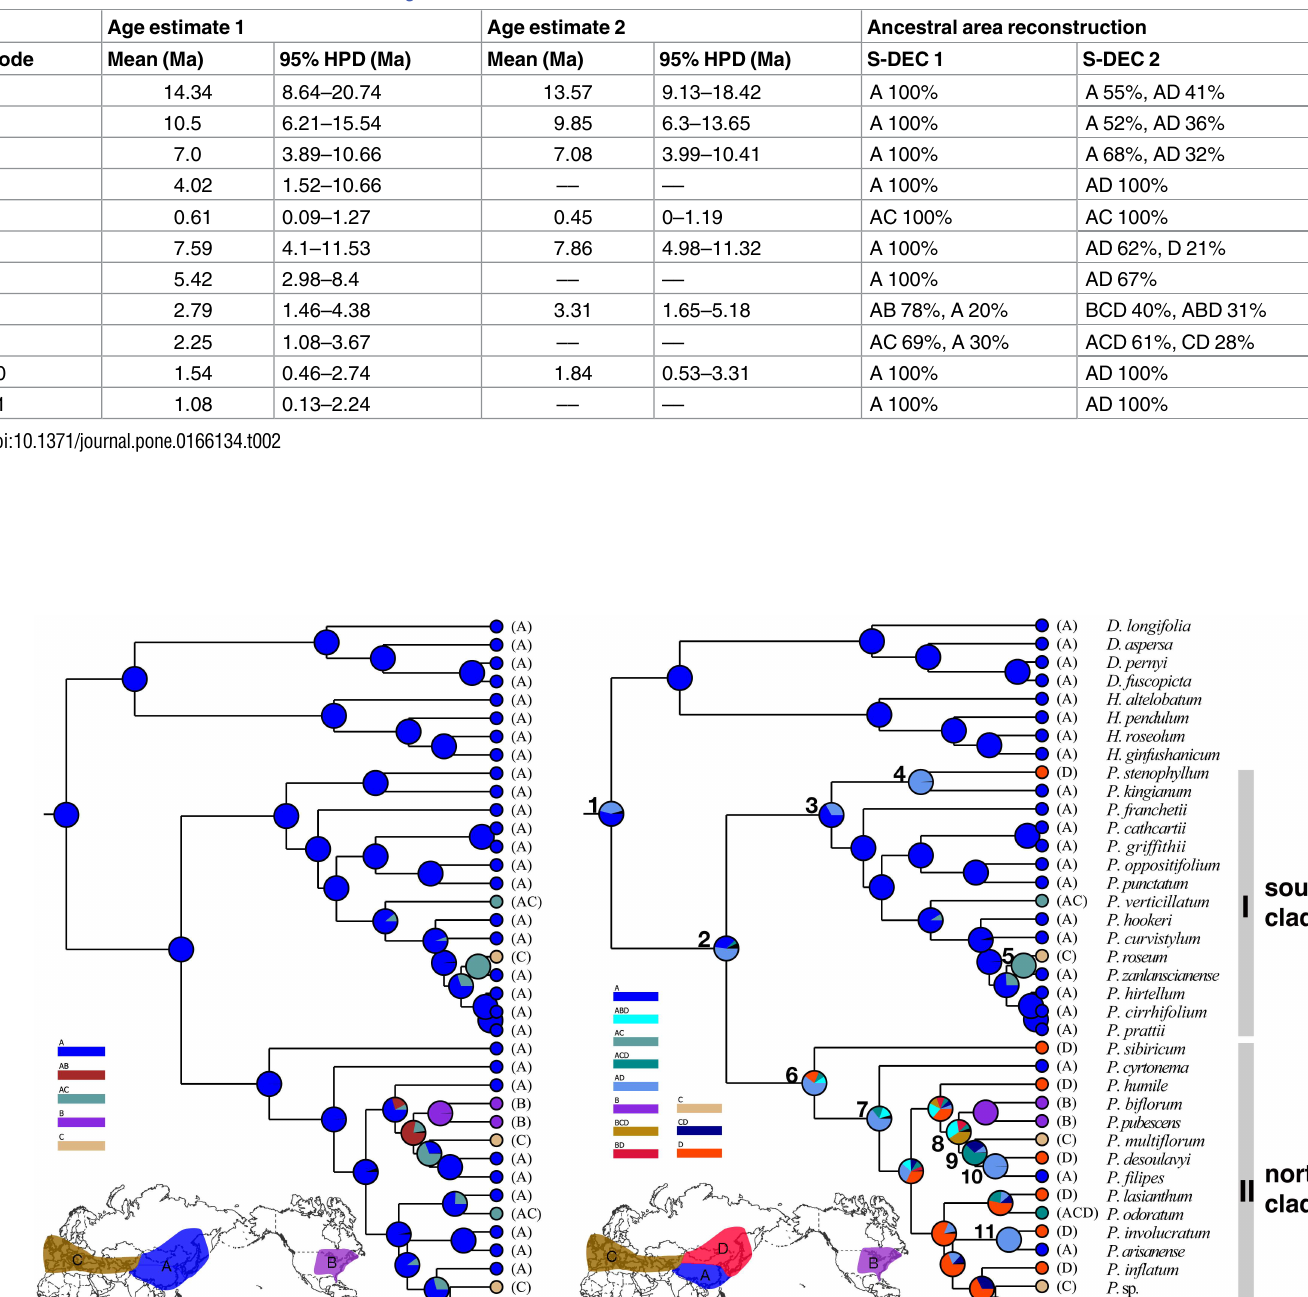
Table 2. Posterior age distributions of major nodes of Polygonatum (Asparagaceae), with results of ancestralarea reconstruction using the S-DEC. Node numbers correlate with those in Fig 2.